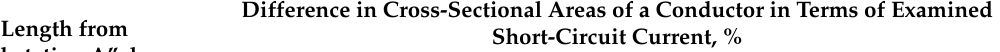
Table 3. Comparison between cross-sectional areas of conductor for “OHL No.1”.